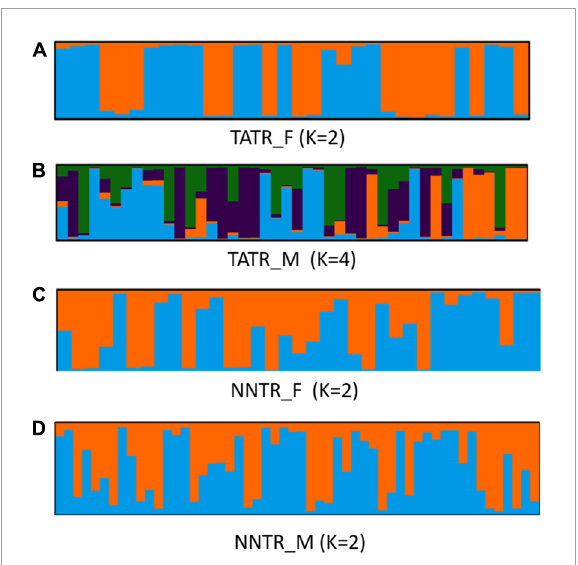
FIGURE2 Bar-plot graph of the estimated membership coefficient of dhole male and female genotypes separately using STRUCTURE. The log-likelihood value confirms the number of clusters (A) TATR_F ( K = 2), (B) TATR_M ( K = 4), (C) NNTR_F ( K = 2), and (D) NNTR_M ( K = 2).